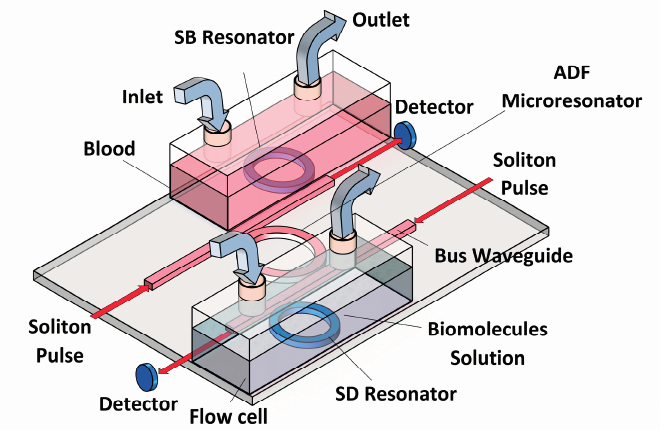
Figure 1. Add-drop filter microresonator with two side rings as biosensing probe inside OWLS flow